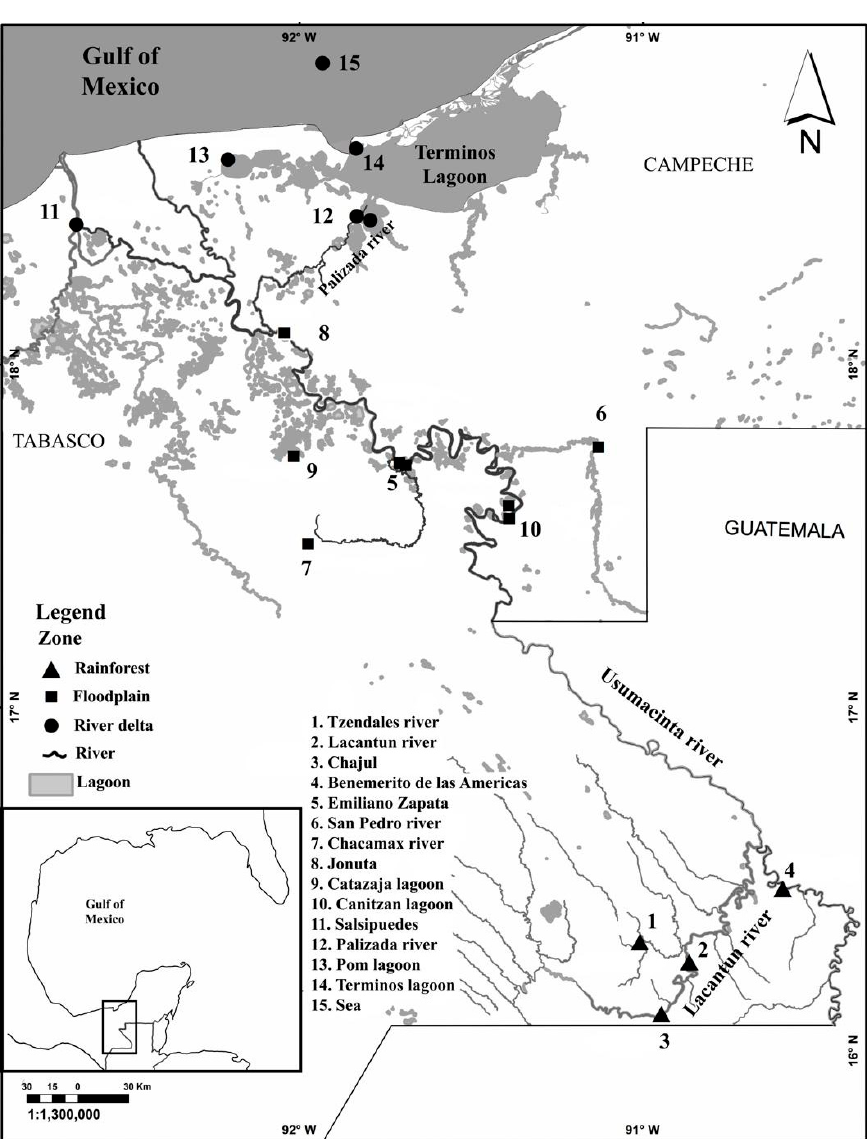
Figure 1. Map of the sampled localities for Centropomus undecimalis . Triangles correspond to the rainforest (RZ), squares correspond to the floodplain (FZ) and the circles correspond to the river delta (RD). Lagoons are represented by the shaded polygons.